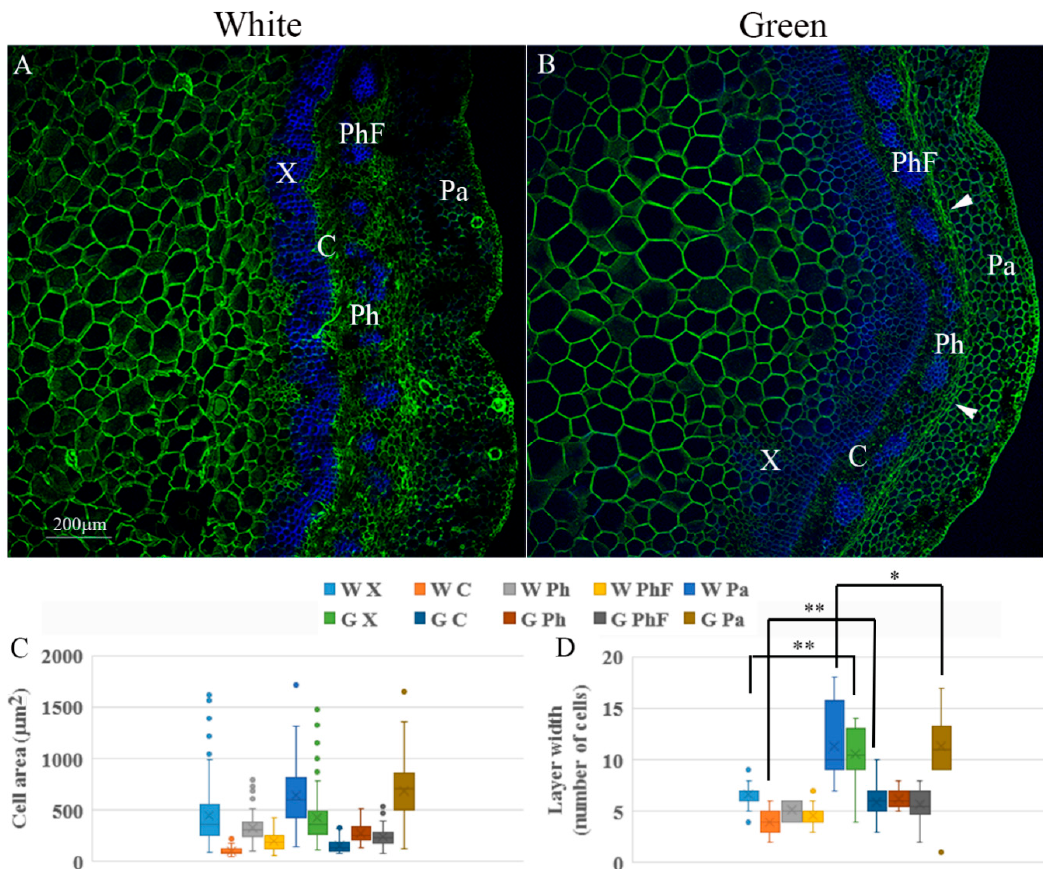
Figure 3. Changes in the different tissues in terms of cell size and number of cells along a line crossing each layer. ( A ) Representative section of a white branch stained with JIM5 (green) and calcofluor (blue). ( B ) Representative section of a green branch stained with LM24 (green) and calcofluor (blue). Arrowheads indicate collapsed cells. Scale bar is 200 µm. X—xylem, C—cambium, Ph—phloem, PhF—phloem fibers, Pa—parenchyma. ( C ) Chart showing average and distribution of cell areas. W— white branch, G—green branch. ( D ) Average number of cells along a line crossing each layer.